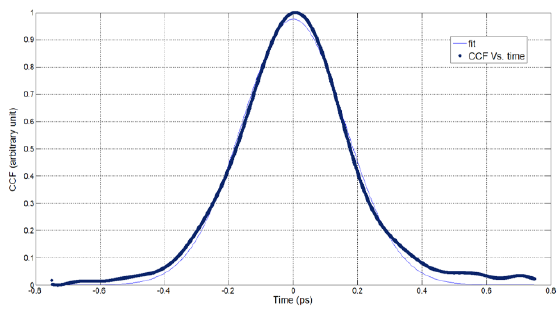
Fig. 2 Cross-correlation of Ti:Sa-OPO and its Gaussian fit